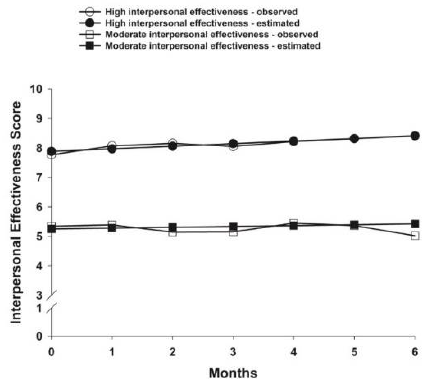
Figure 3. Observed and estimated attentional lapses latent classes from prior to through to 6 months after breast cancer surgery.